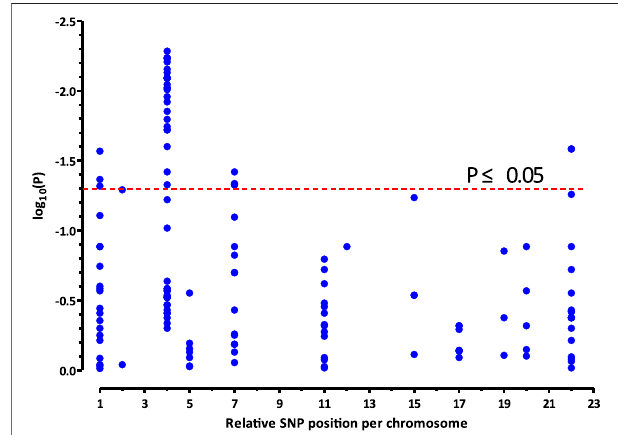
FIGURE 1 | Signi fi cances (plotted as − log10 of nominal p values, closed blue circles) resulting from the associations between the investigated SNPs and different response (apnea-free vs. apneic) to caffeine therapy in preterm infants ( n (cid:1) 112). The x -axis represents the relative genomic position/ chromosome, and the y -axis represents the distribution of the nominal − log10( P ) values in the two groups ofinfants. The 26SNPs, which are associated with the response to caffeine treatment ( p < 0.05; above stippled red line), map to the CLOCK gene located on chromosome